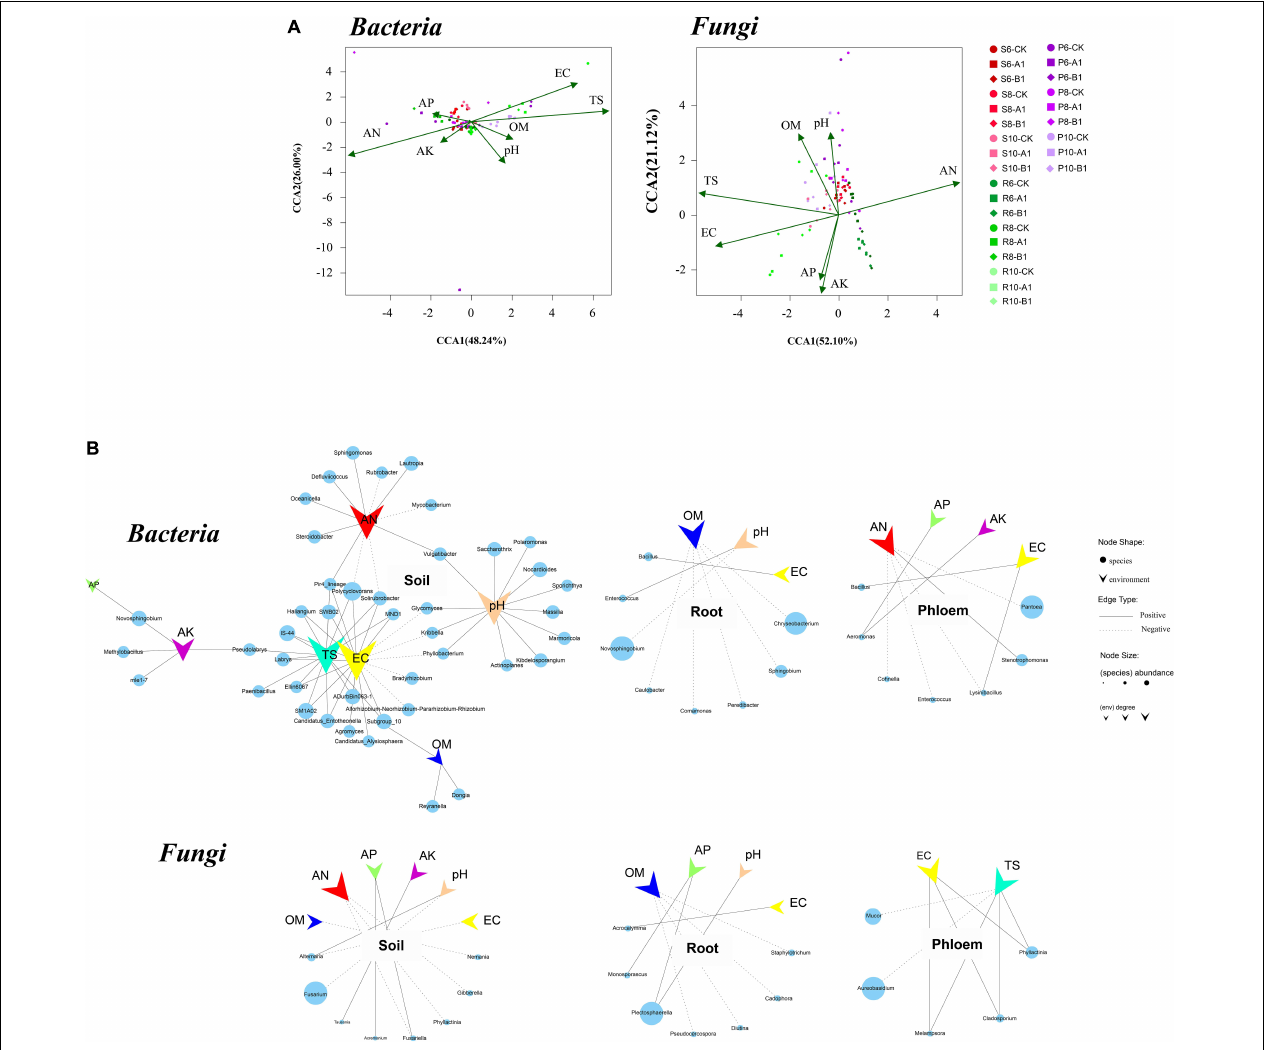
FIGURE 4 | Canonical correspondence analysis (CCA) and correlation analysis between microbes and environmental factors. (A) Distance-based CCA of bacterial and fungal communities in all samples. (B) Correlations between genera and environmental factors. Each circle represents one genus of bacteria or fungi, and its size represents the average abundance across the corresponding habitats. The vee represents environmental factors. The figure shows only genera significantly associated with environmental factors, with a coefficient greater than